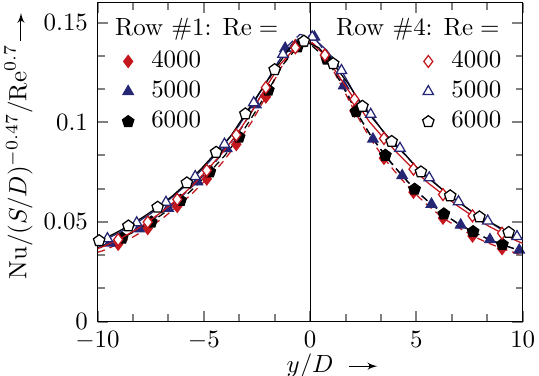
Figure 12. Combination of the influence of S / D and Re on Nu at row #1 and